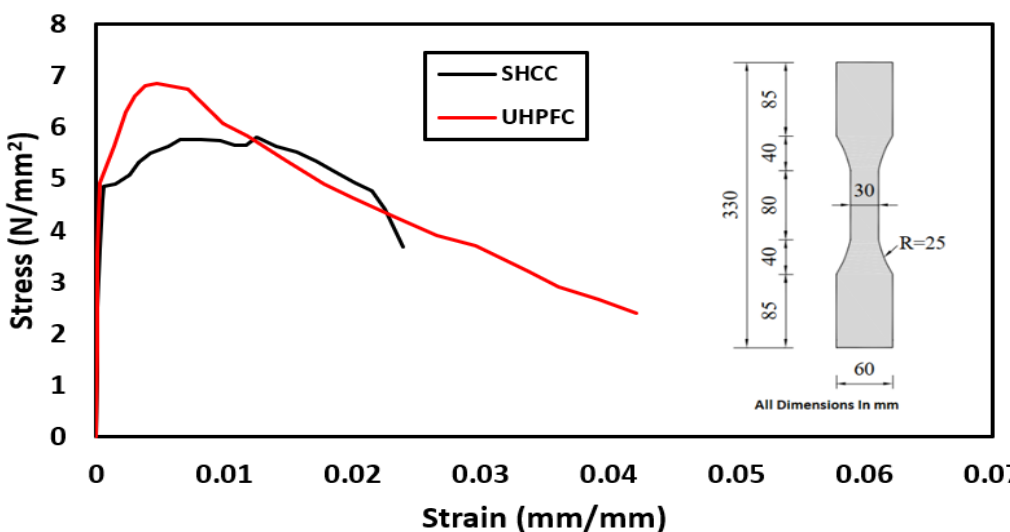
Figure 4. Wood formwork and casting work.